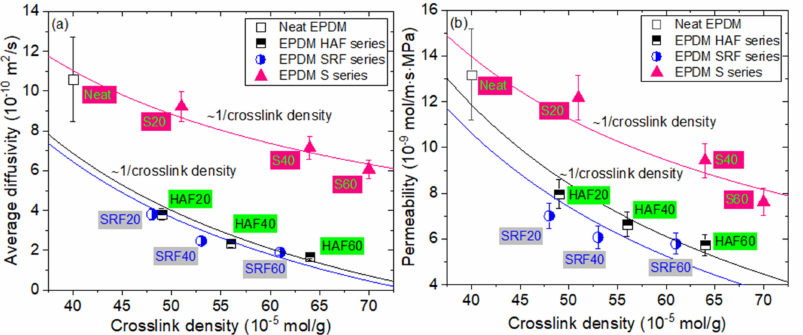
Figure 9. Linear correlation between the ( a ) average diffusivity and ( b ) the permeability and reciprocal crosslink density for neat EPDM and EPDM composites blended with filler. The solid lines represent the least squares fitting results, indicated as the average diffusivity and permeability proportional to ~1/crosslink